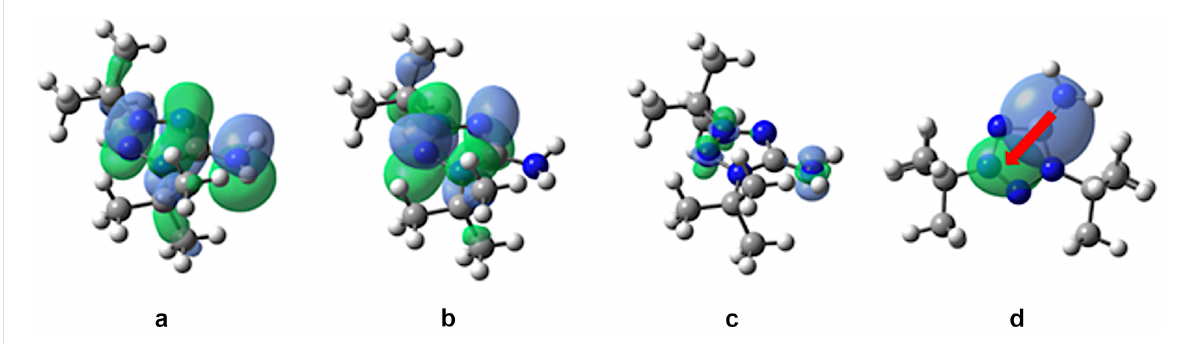
Figure 7: The calculated plots in water of a) HOMO, b) LUMO, c) electron density difference between the S 1 and S 0 states, and d) the S 0 → S 1 CT. Green (blue) regions (for c and d) indicate an increase (decrease) in the electron density upon electronic transition. The red arrow shows the charge